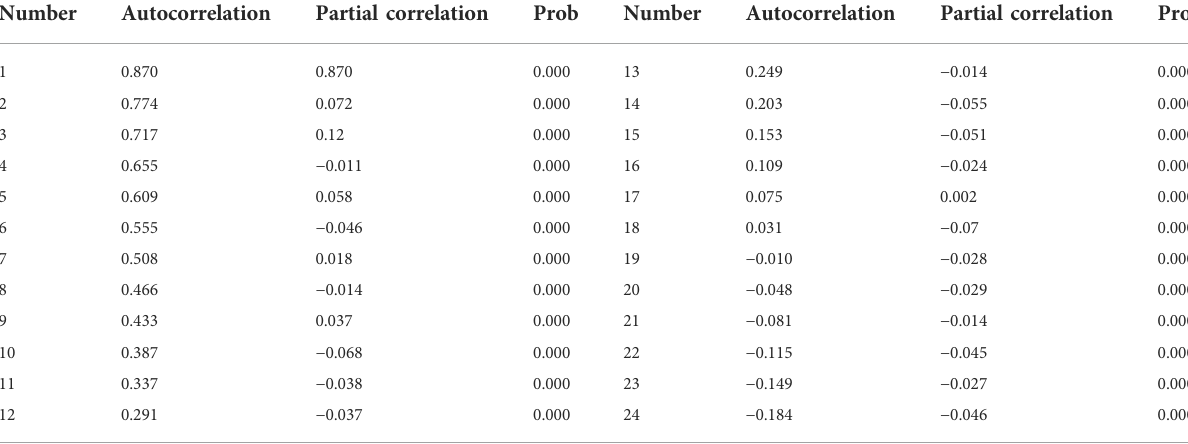
TABLE 1 Autocorrelation and Partial Correlation coef fi cient of the coal prices